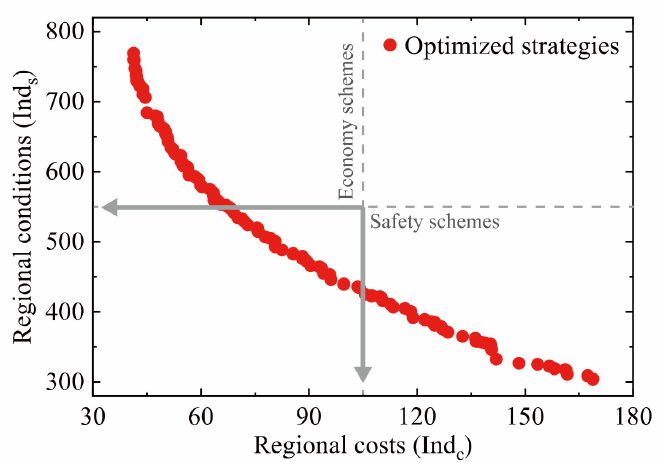
Figure 10. The optimal maintenance schemes for 2000 bridges.